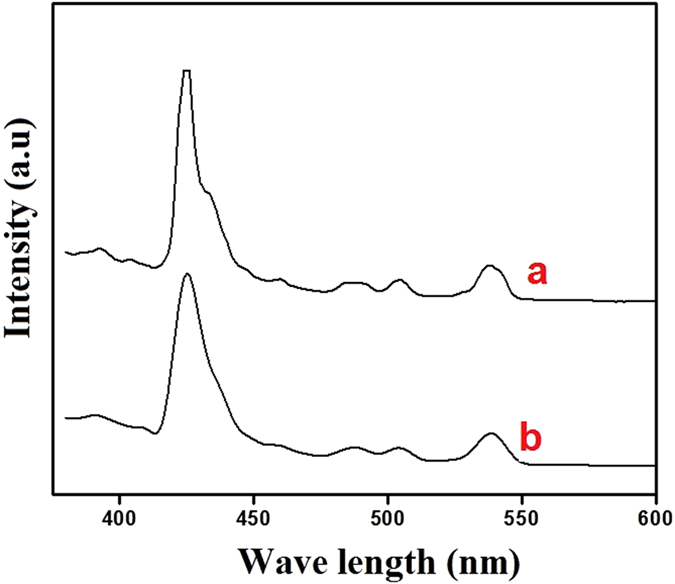
Photoluminescence emission spectra of (a) CeO2 NPs prepared by the MCM method and (b) CeO2 NPs prepared by the CRSGM.